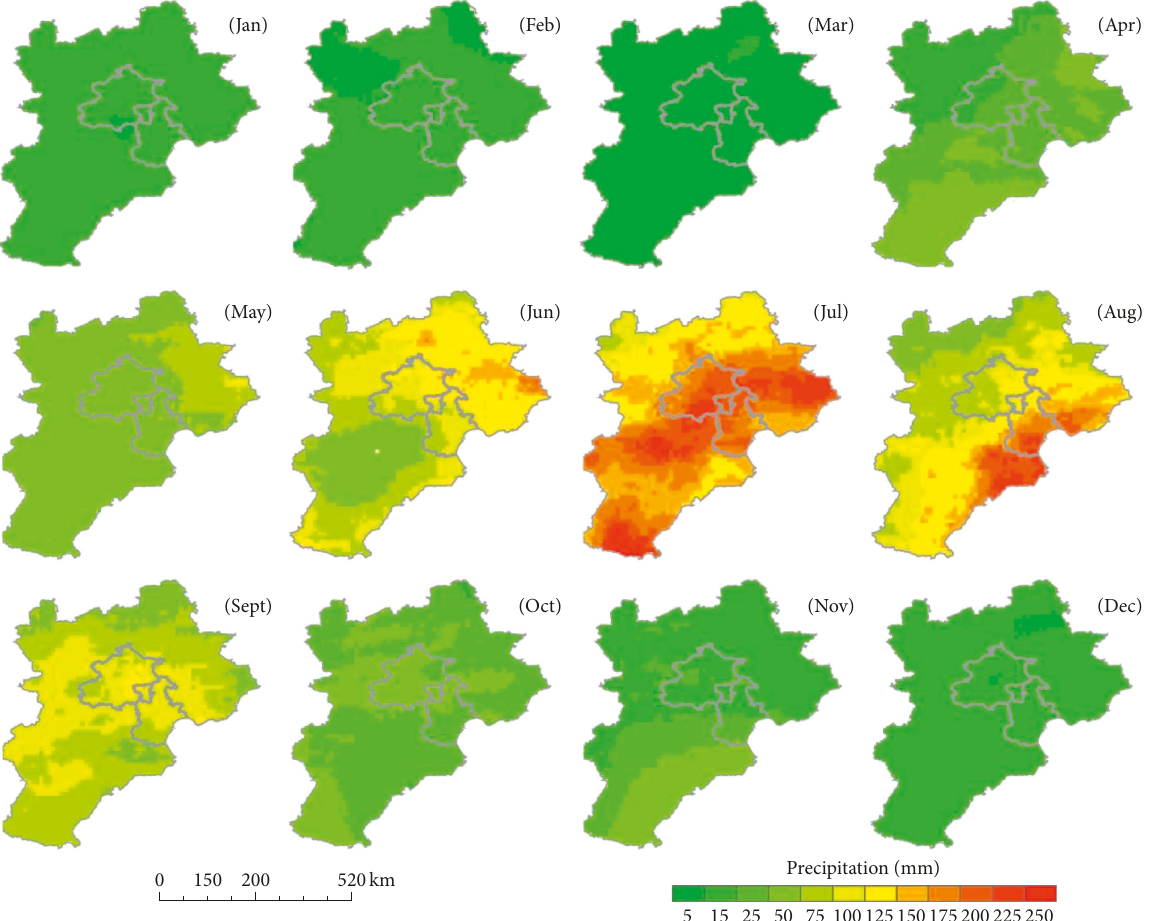
Figure 10: Spatial distribution of mean monthly precipitation in the study